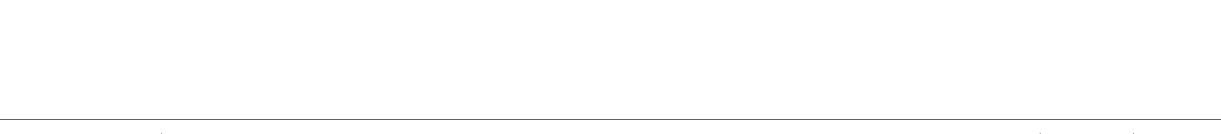
Frontiers in Physiology |